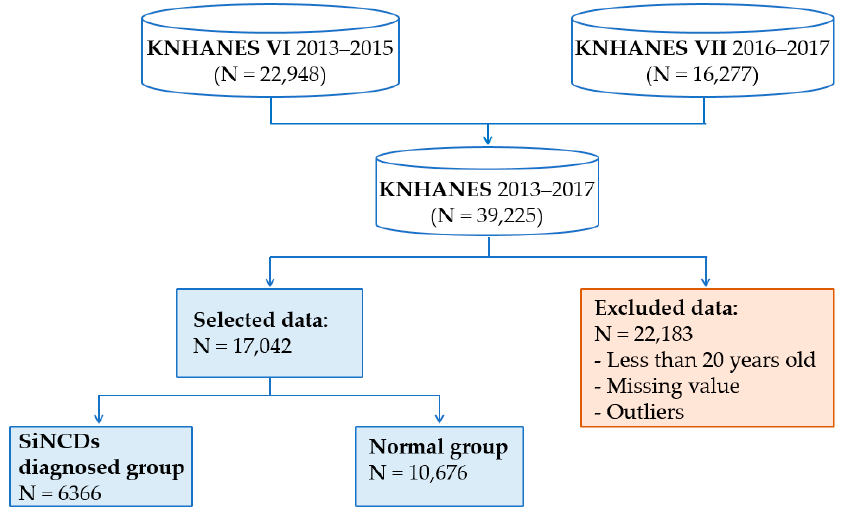
Figure 3. Sample selection procedure of the Korea National Health and Nutrition Examination Survey (KNHANES) dataset.